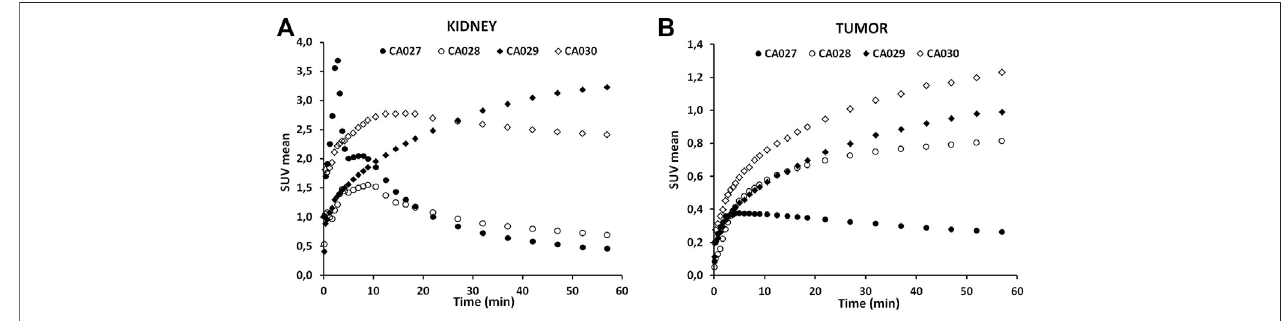
FIGURE4| Time – activity curvesofthenovel PSMAligands labeled withthe 68 Gafor kidney (A) and for thetumor (B) upto1 h postinjection. Dataare meanSUVs.